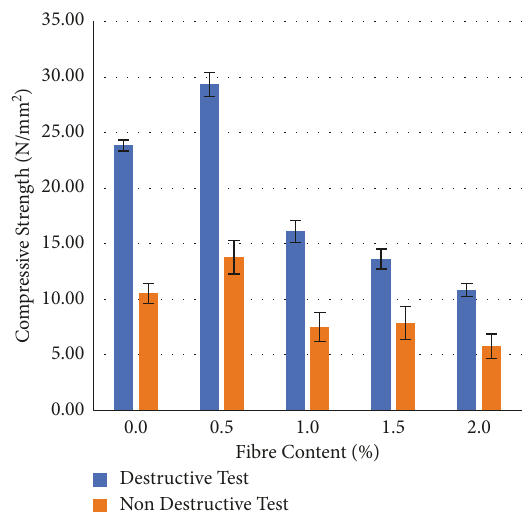
Figure 3: Comparison between nondestructive and destructive cube test results for PET